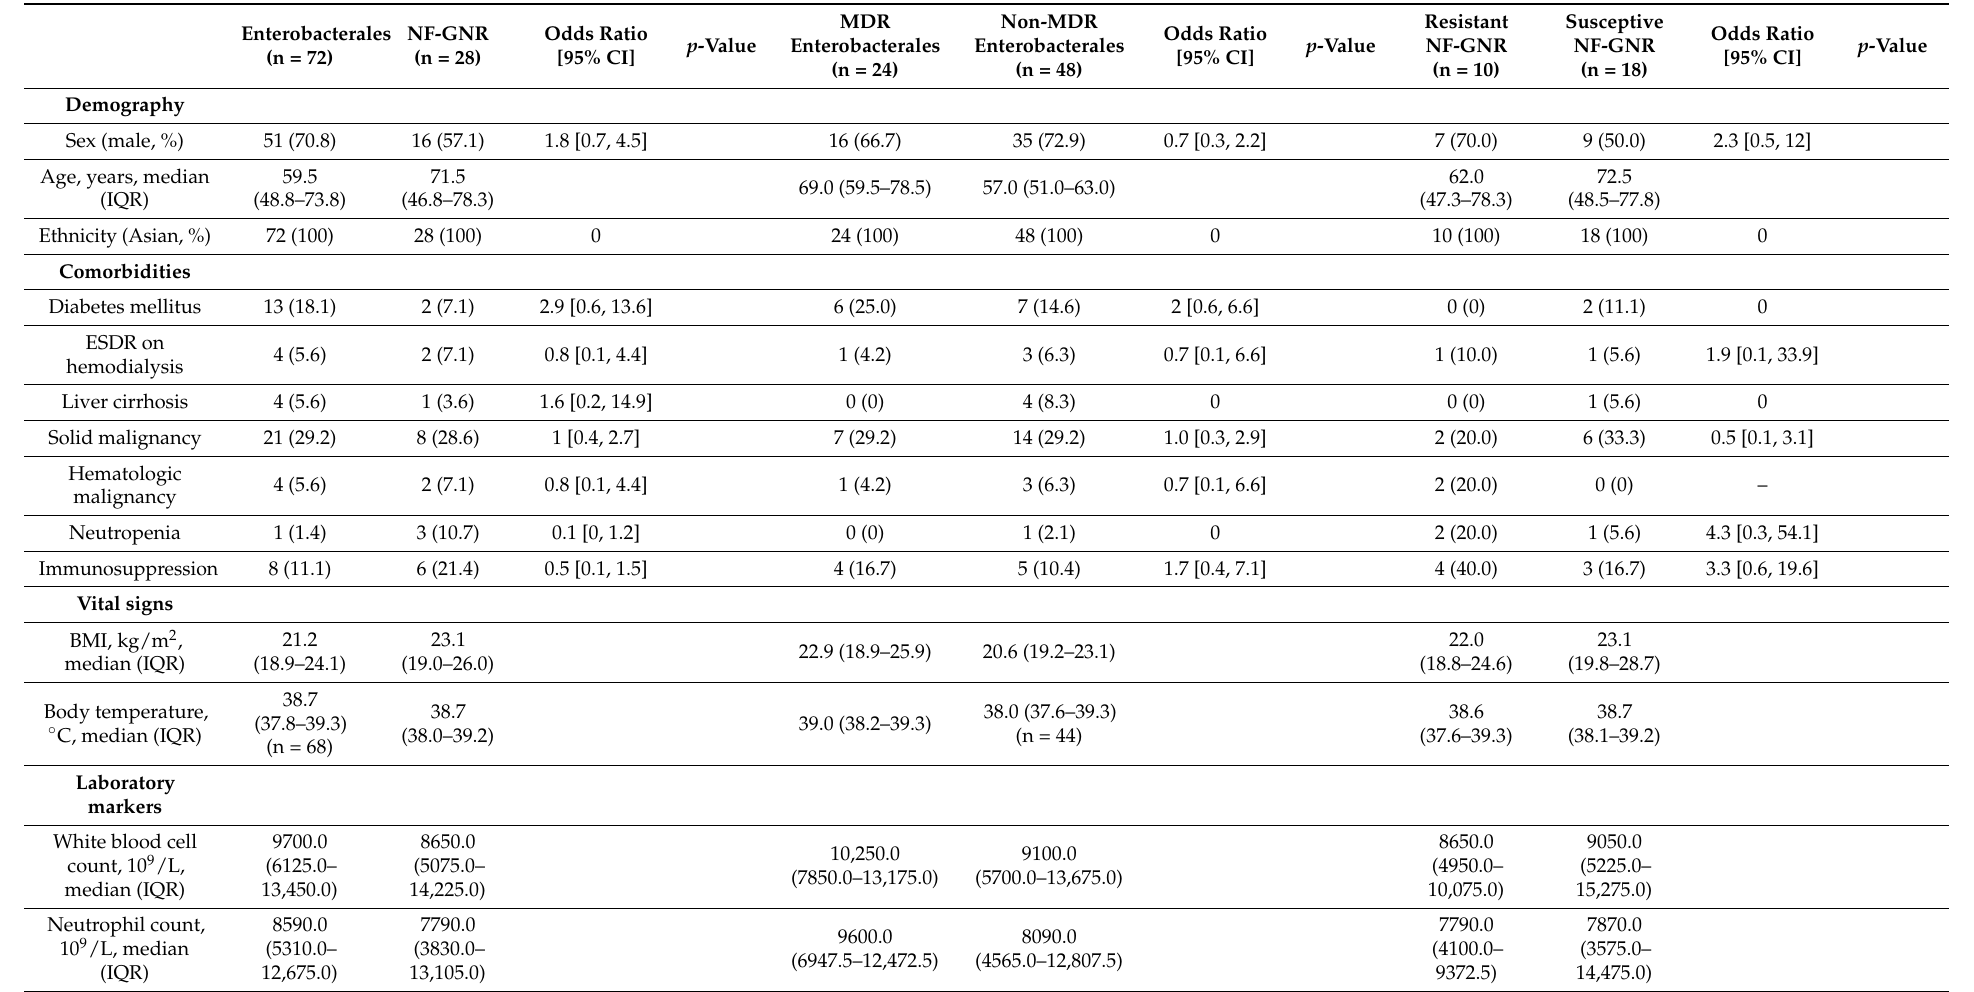
Table 1. Clinical characteristics of persistent bacteremia between Enterobacterales and glucose non-fermentative gram-negative rods and in terms of antimicrobial resistance